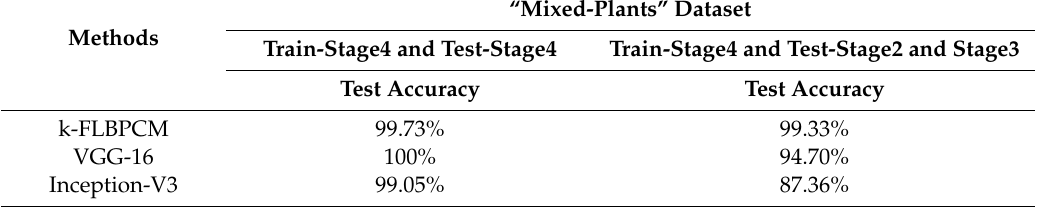
Table 7. Comparison of the classification accuracies of the VGG-16, Inception-V3 and k-FLBPCM methods when mixed-barley–canola and mixed-barley–radish images collected at di ff erent growth stages are used for the